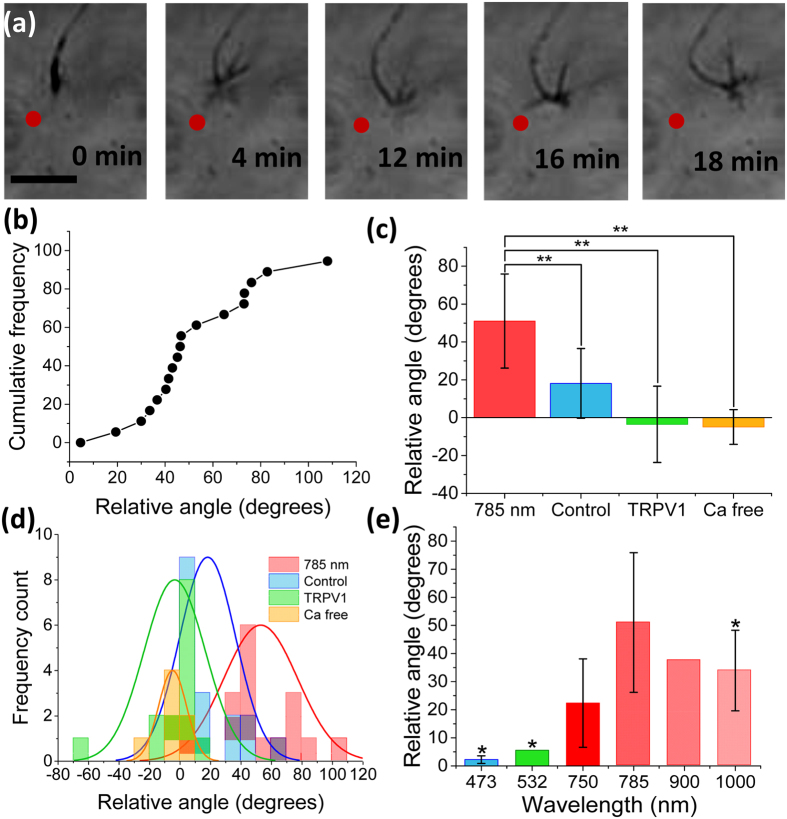
Mechanism of light-induced repulsive axonal guidance.(a) Time-lapse images of primary cortical axon responding to asymmetrical positioning of weakly-focused (0.5 NA) laser (80 mW at 785 nm) spot (marked by red spot). Scale bar: 10 μm. (b) Cumulative frequency (in %) of relative turning angle in response to single guidance by a static laser spot. (c) Relative angle turned in the cases of positive control (785 nm, laser on, red), negative control (laser off, blue), silenced (785 nm, laser on, 10 μM SB-366791, TRPV1 antagonist, green), and calcium-free (785 nm, laser on, Ca-free medium, orange) guidance trials. Statistical significance between trial groups (**p < 0.01). Average ± S.D. (d) Frequency counts for the four major experimental groups. Lines indicate a 100% scaled normal fit. (e) Relative angle turned in response to the laser cue at various wavelengths (473, 532, 750, 785, 900, 1000 nm). *Sample-site laser power at 473, 532, or 1000 nm were <80 mW (used for 750, 785, 900 nm). Angles reported are from trials in which the axon grew to the static position of the laser spot.